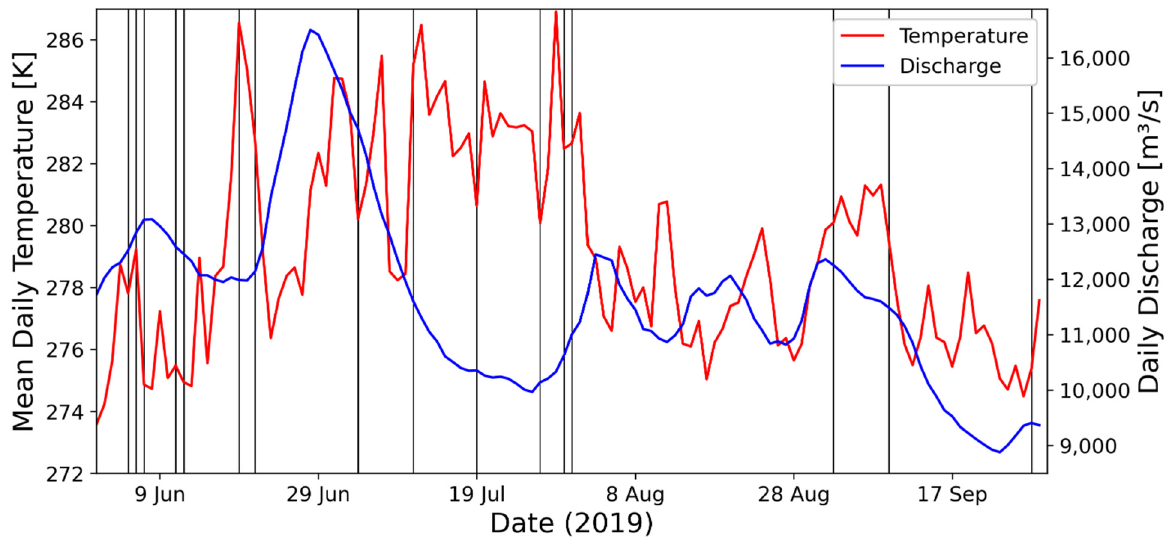
Figure 4. Mean daily temperature from the weather station at HIQ between 1 June and 30 September (red) and daily Mackenzie River discharge measured at Arctic Red Tsiigehtchic for the same time period (blue). Black lines indicate the dates of satellite image recordings.